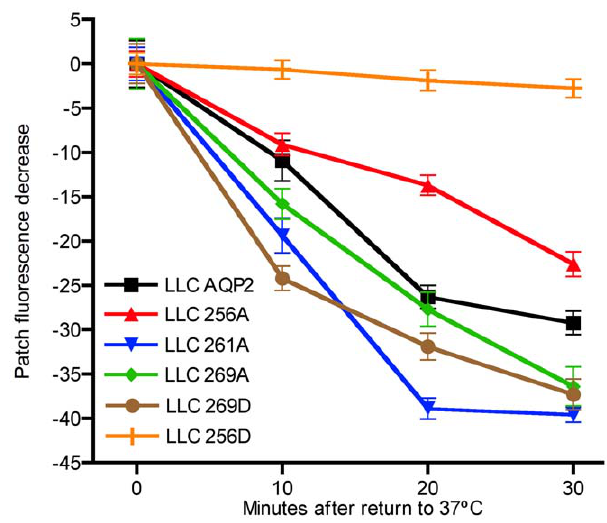
Figure 5. Quantified dissolution of the AQP2 perinuclear patch after cold block release. To quantify the rate of AQP2 redistribution a time course analysis of the dissolution of the patch was assayed by immunofluorescence staining and images were quantified using the IPlab software. The results are presented as the decrease from the maximum mean patch fluorescence value after release of cold block. The experiment was repeated in triplicate N for each mean is . =24. Bars represent standard